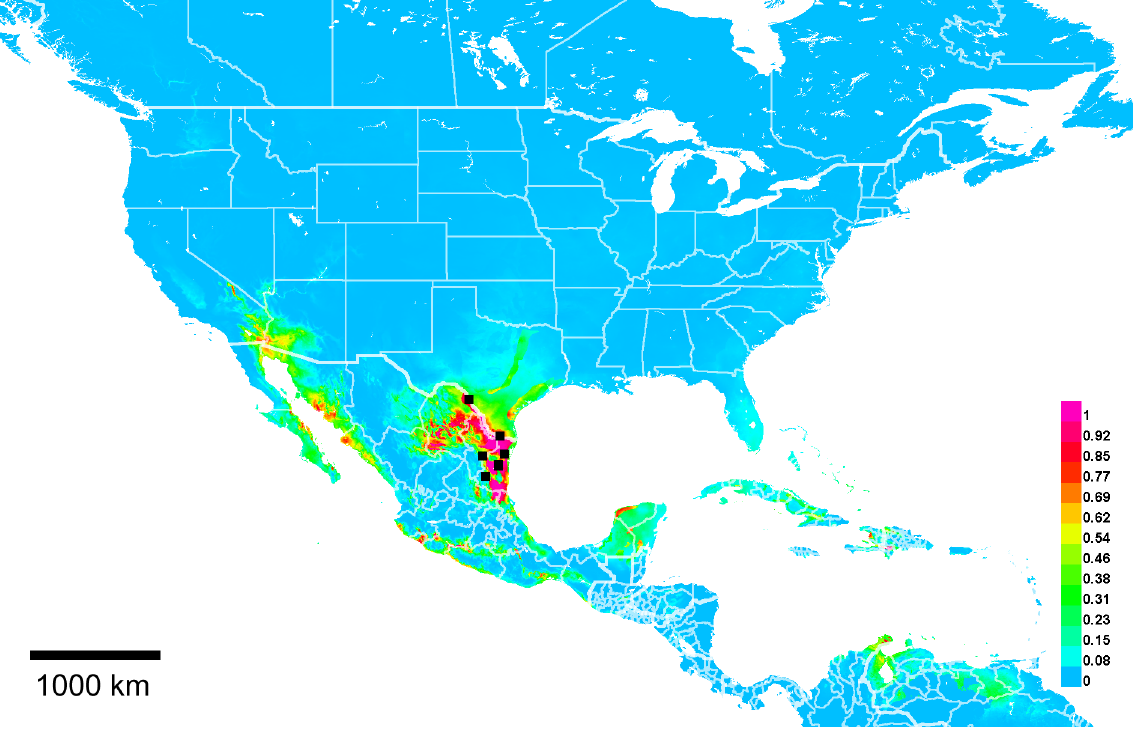
Fig. 59. Georeferenced collection records of Lasioglossum ( D .) rufodeludens sp. nov. (black squares) and predicted distribution by maximum entropy ecological niche modelling in Maxent (colour shading). Warmer colours indicate higher cloglog probability of